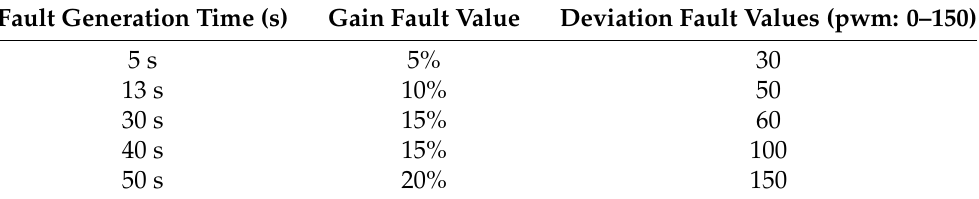
Table 1. Actuator fault data of the quadrotor.